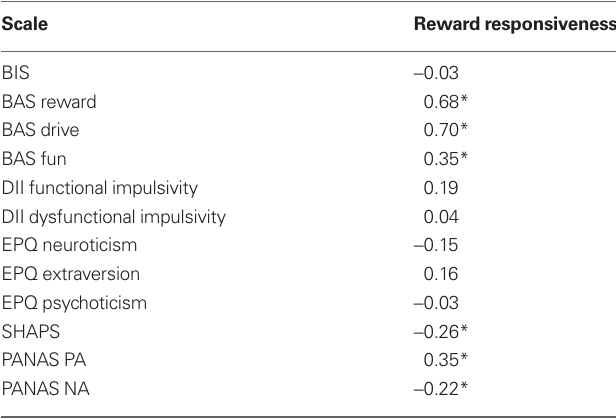
Table 3 | Pearson correlation coefficients between the RR scale and various other questionnaires (Study